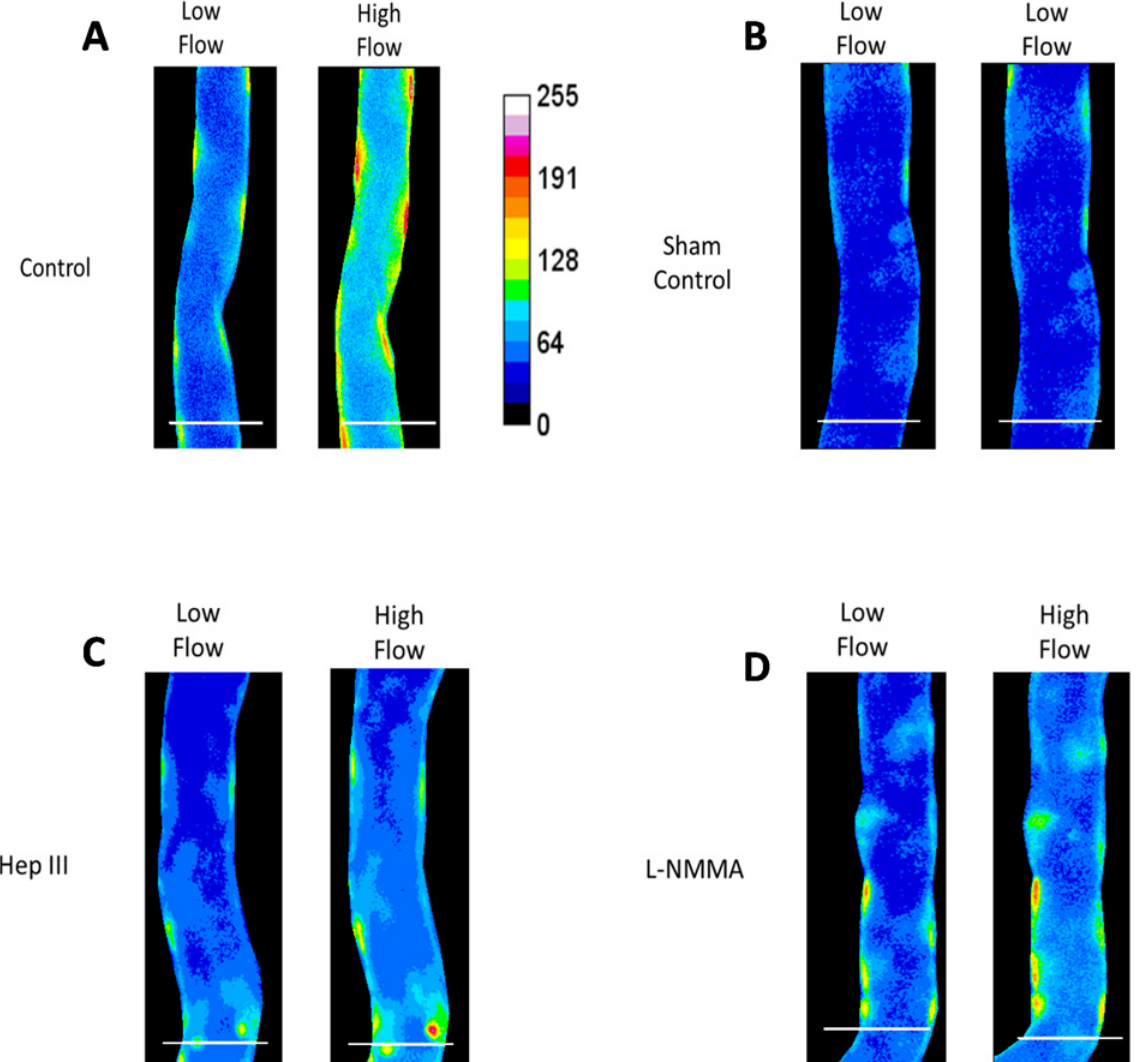
Figure 2. Representative DAF-2 fluorescence images for post-capillary venules. Images were taken after 10 min low flow (left panel) and an additional 60 min high flow (right panel). A) control (1% BSA Ringer); B) sham control (low flow over entire time); C) 1 h pretreatment of heparinase III; and D) in the presence of L-NMMA. Scale bar is 50 μ m.